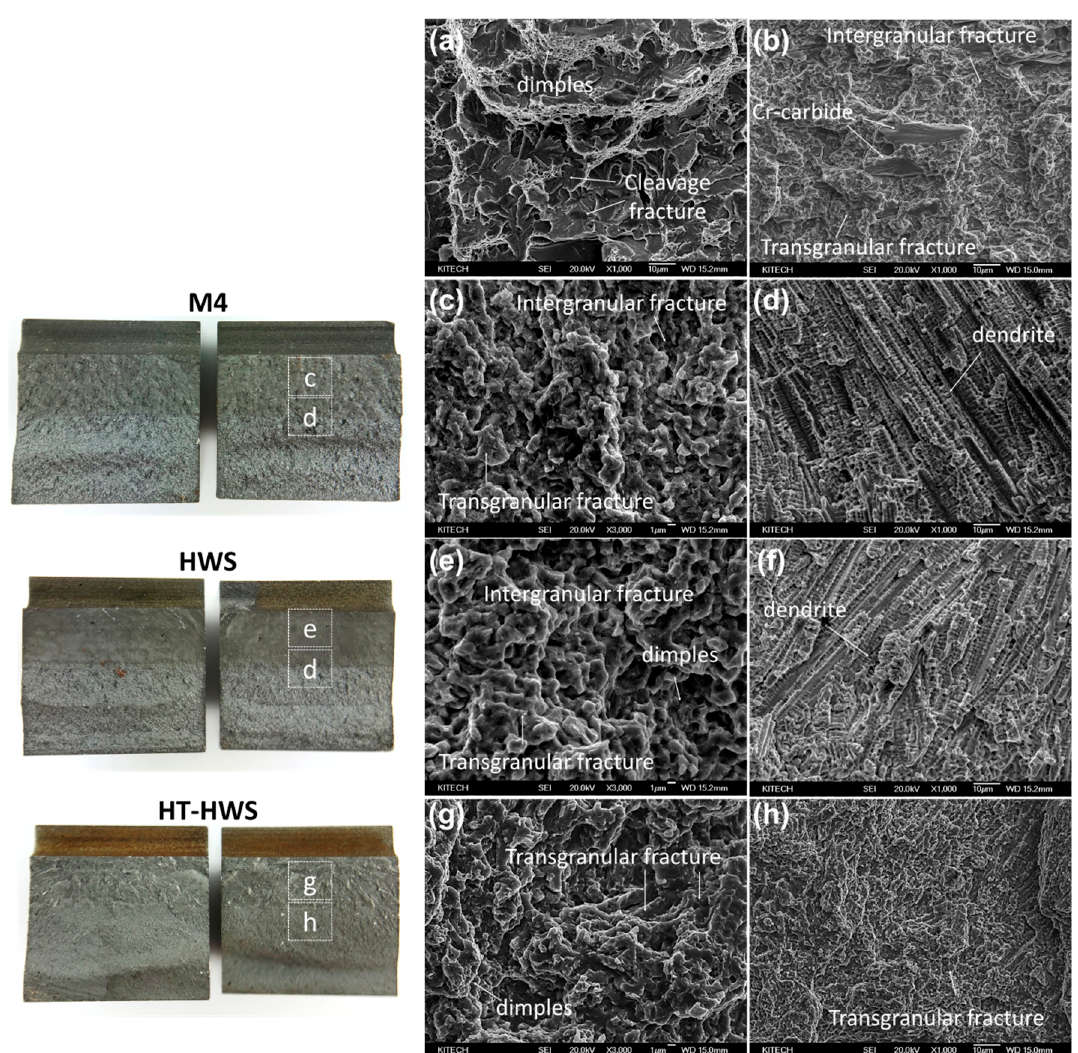
Figure 11. Micro-images of the fracture surface: ( a ) Substrate D2, ( b ) HT-D2, ( c ) deposited M4 layer, ( d ) interface of the M4 deposits, ( e ) deposited HWS layer, ( f ) interface of the HWS deposits, ( g ) deposited layer of HT-HWS, and ( h ) interface region of HT-HWS.